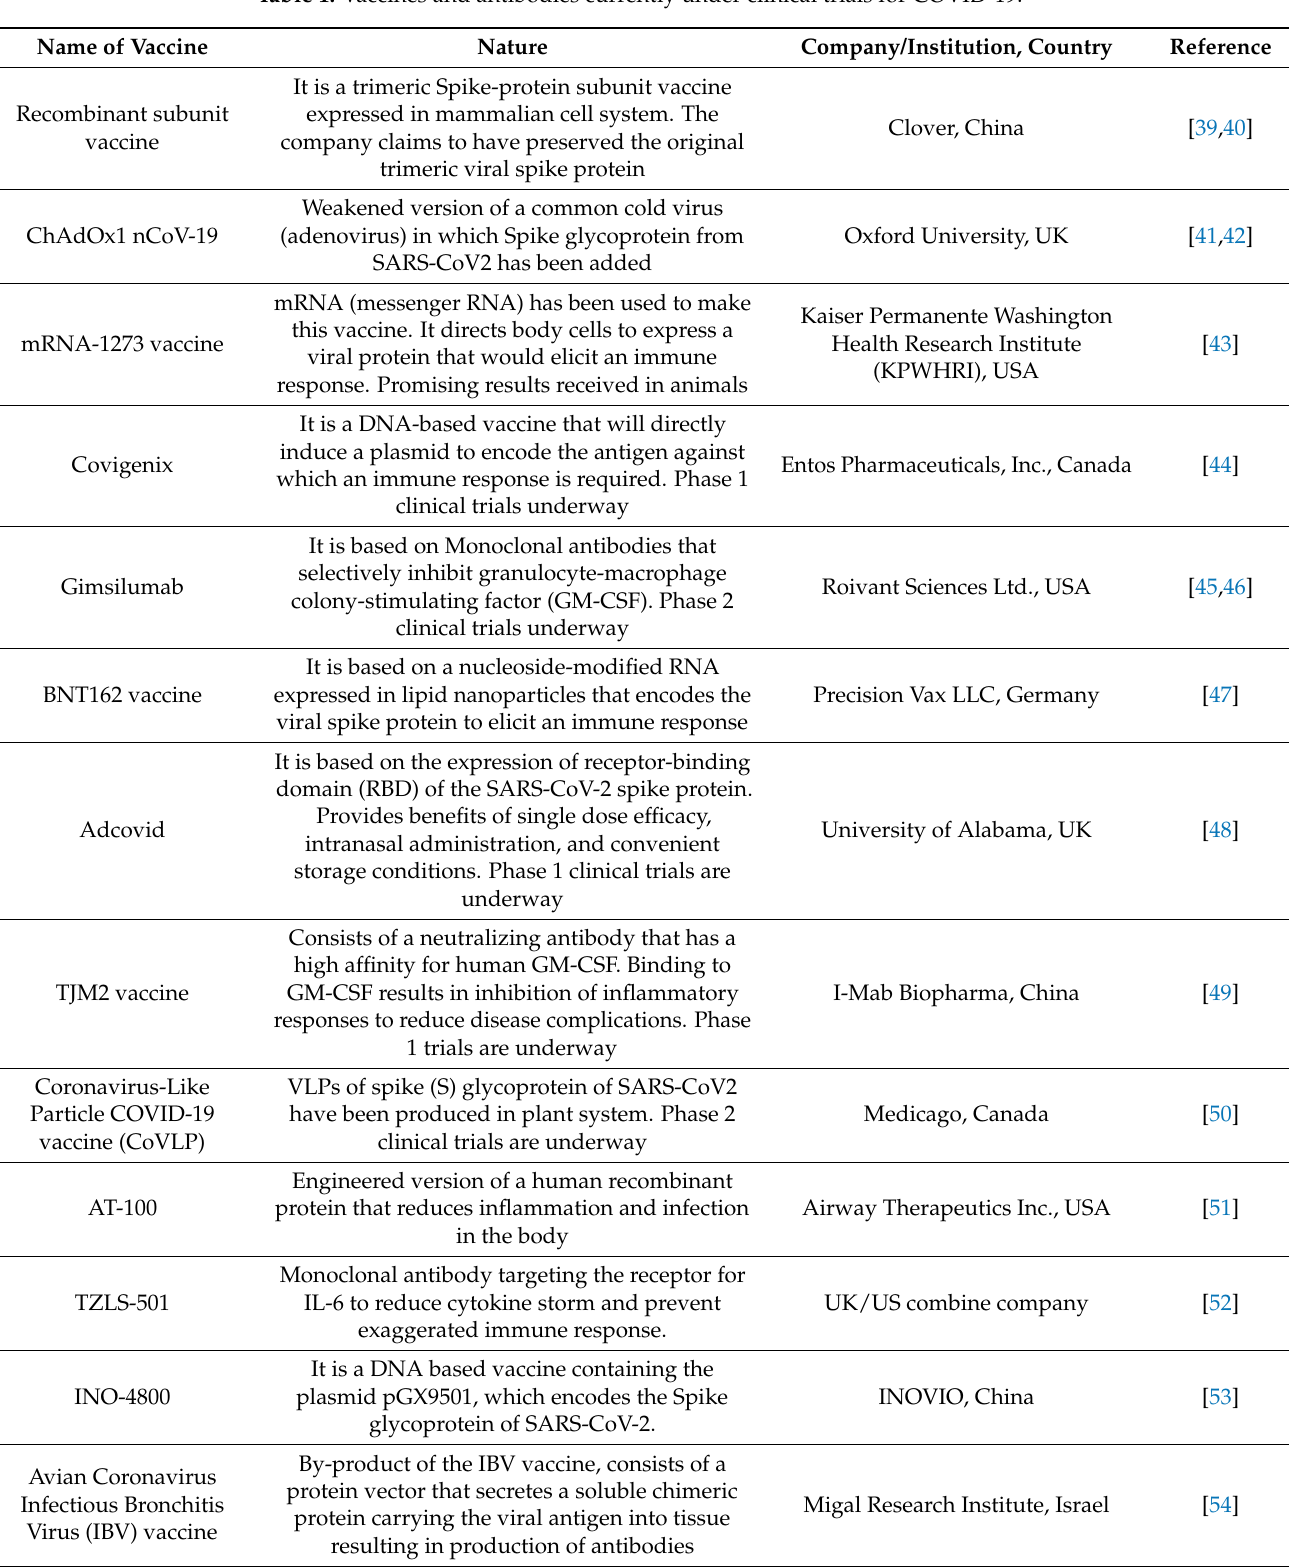
Table 1. Vaccines and antibodies currently under clinical trials for